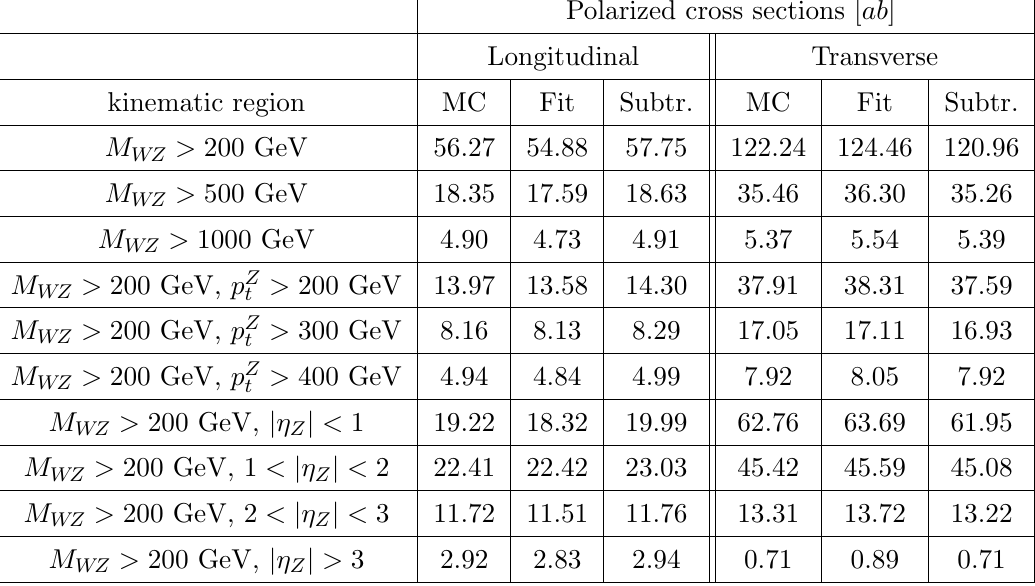
Table 18 . Cross sections ( ab ) for a longitudinal and transverse Z in W + Z scattering, in the Higgsless model, in several kinematic regions: comparison of MC predictions for the Higgsless model with results obtained via (cid:12)t and subtraction procedure. The subtraction procedure results for a transverse Z coincide with the SM cross sections.